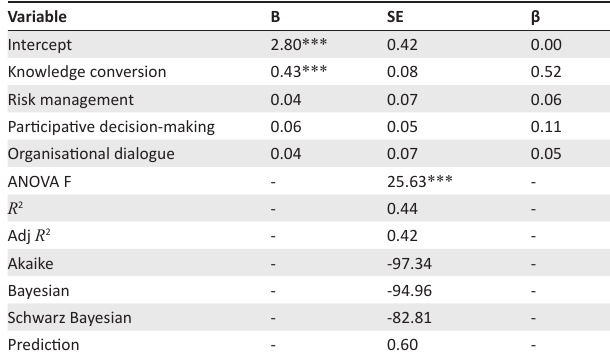
TABLE 5: Linear regression results for the effect of organisational dialogue on social innovation (Hypnotises 5). Variable B SE